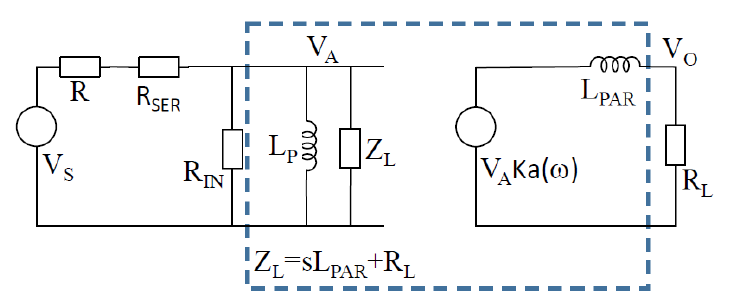
Figure 5. Circuit implementation of the model of Equation (7). The transformer is inside the dashed rectangle, and the termination resistors are outside.